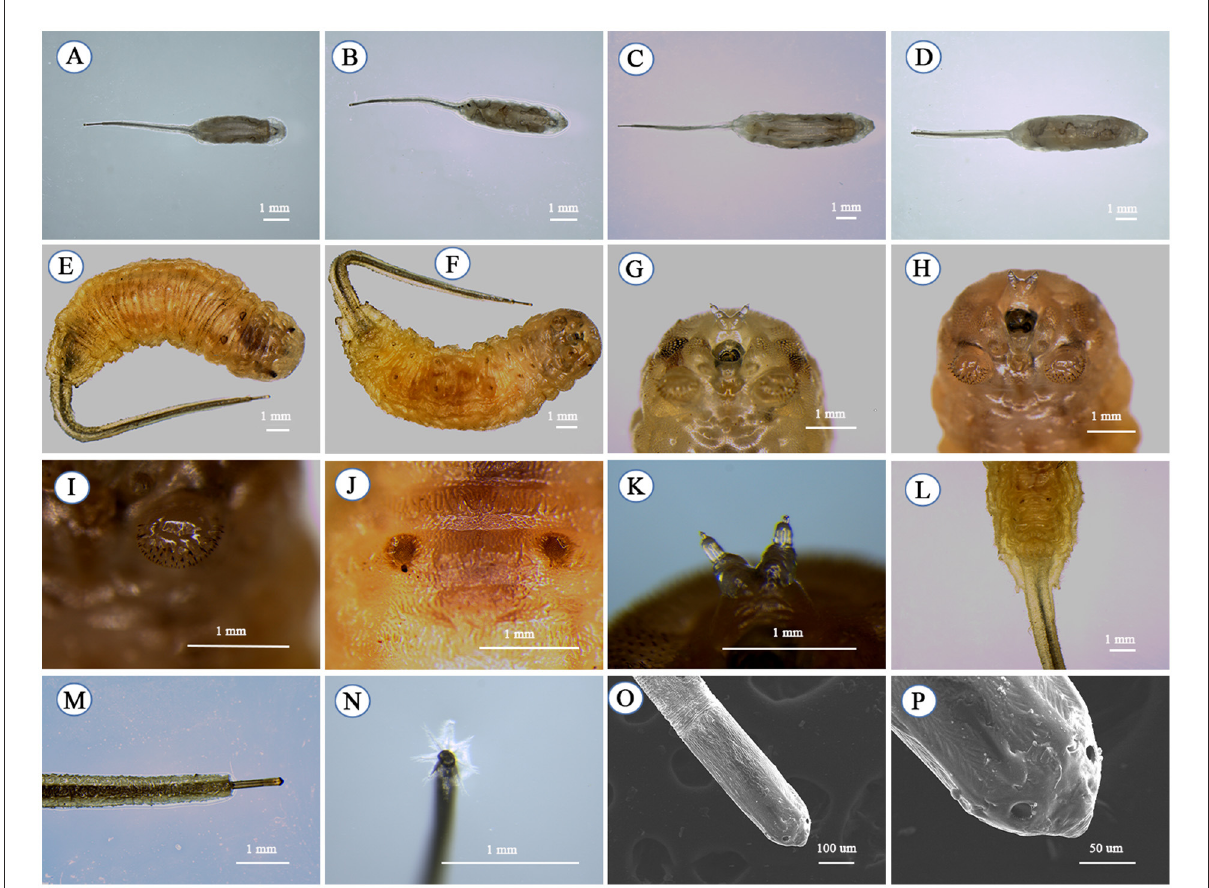
FIGURE3 Larva of Eristalinus arvorum ; first-instar larvae: (A) dorsal view and (B) ventral view; second-instar larvae: (C) dorsal view and (D) ventral view; third-instar larvae: (E) dorsal view, (F) ventral view, (G) frontal view, (H) frontal view, (I) midthoracic gastropod, (J) pupal respiratory horn foramen, (K) antennomaxilary organs, (L) the anus, (M) posterior tracheal canal, (N) posterior trachea plate tip feathers, (O) posterior valve tip, and (P)